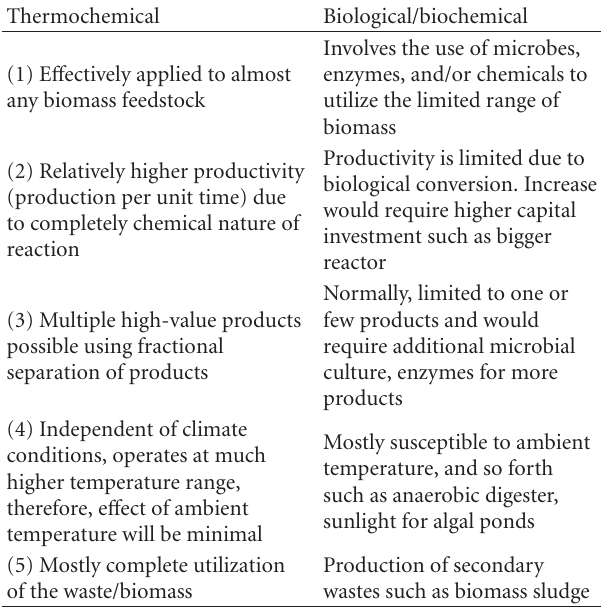
Table 1: Advantages of thermochemical conversion of biomass over biological/biochemical